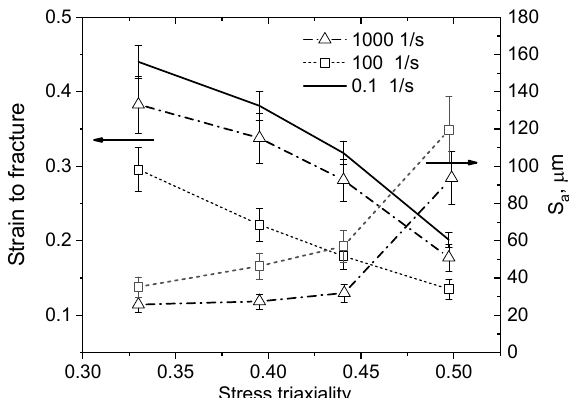
Figure 11. Strain to fracture versus stress triaxiality; fracture surface roughness S a versus stress triaxiality.